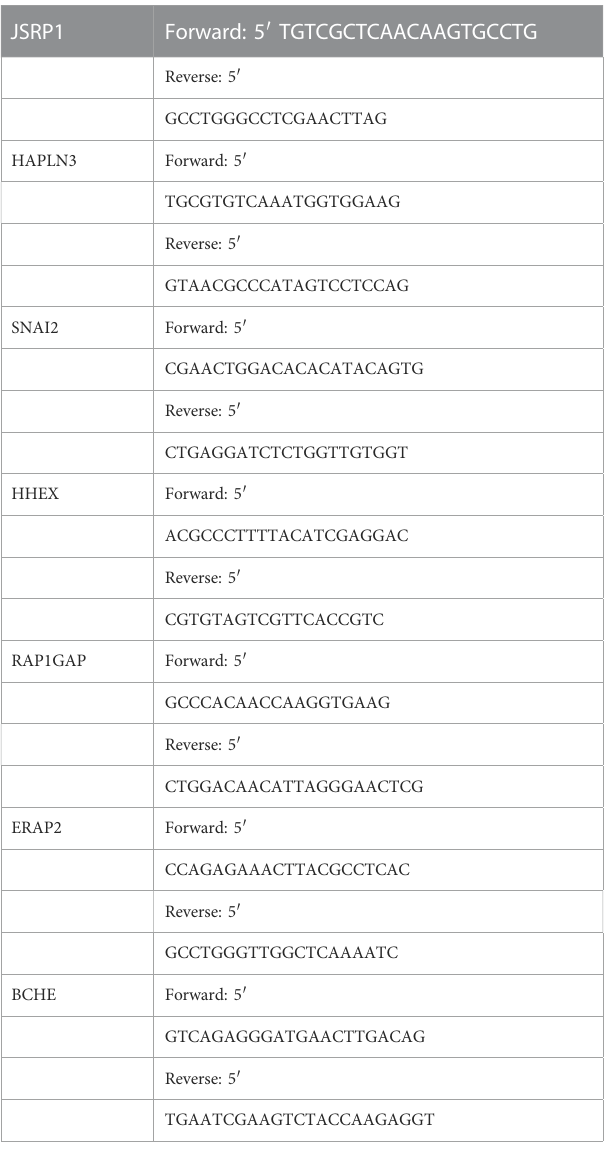
TABLE 1 The primers for 7 cuproptosis-related differential